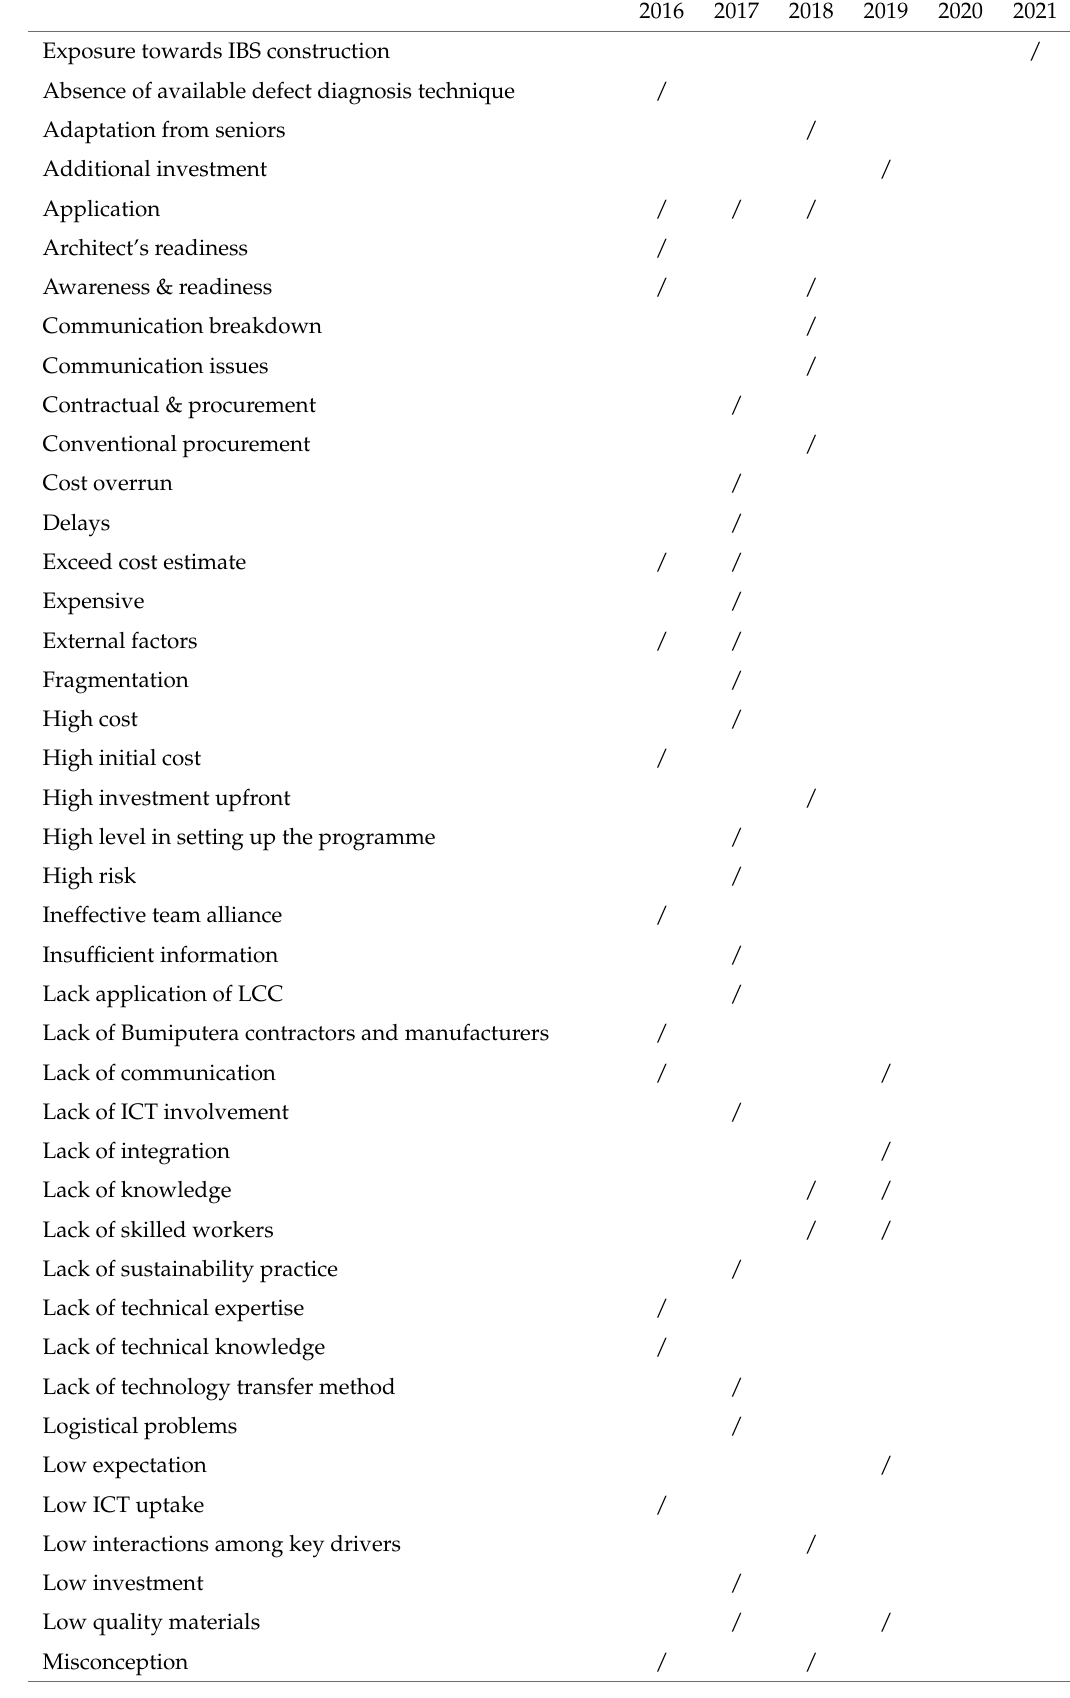
Table 2. Initial coding on IBS